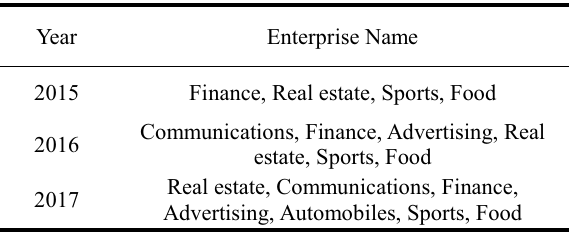
Table 3 The age of contestants in the "dragon boat race" of